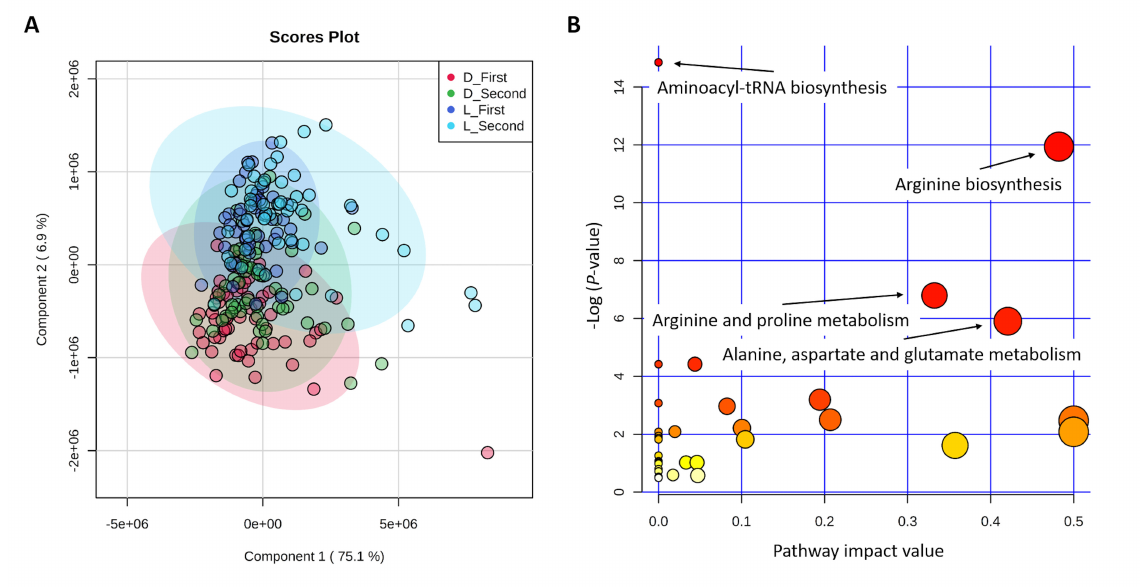
Figure 1. ( A ) Partial least squares-discriminant analysis (PLS-DA) of 45 metabolites. Note: D / L with first / second indicates the sampling time of Duroc / Landrace pigs. ( B ) Metabolic pathways for 45 metabolites using Homo sapiens as the library. Note: The size and color of the circles for each pathway indicate the matched metabolite ratio and the − log ( p -value),